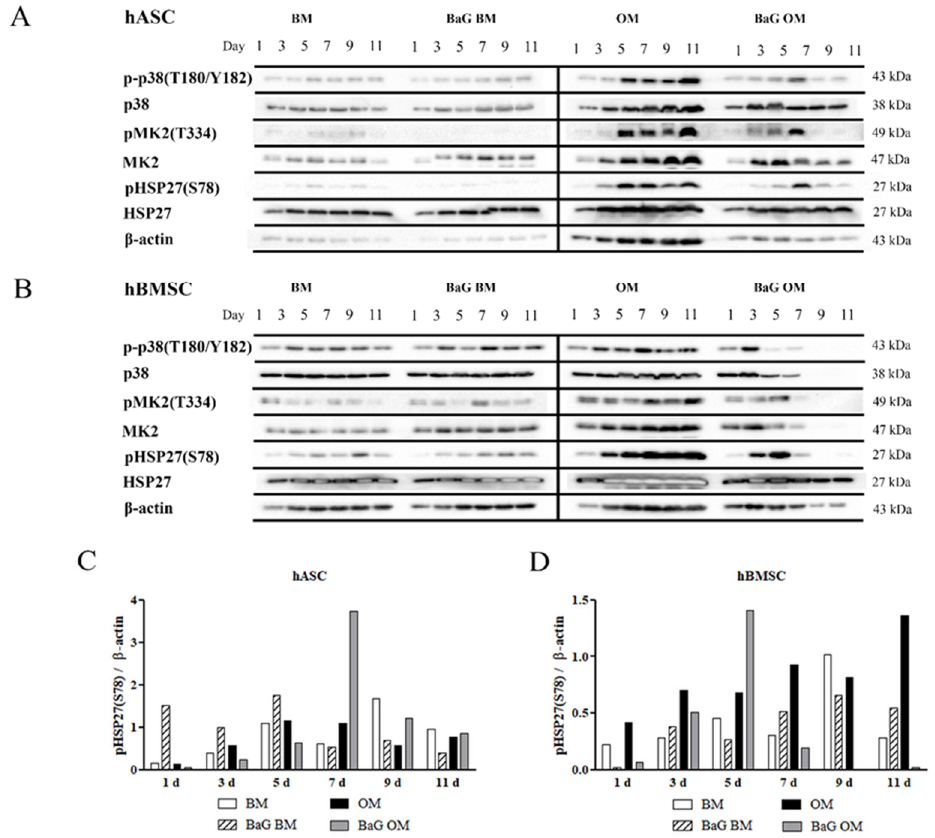
Figure 2. Timeline of p38/MK2/HSP27 activation in hASCs and hBMSCs. ( A , B ) hASCs and hBMSCs were cultured in BM, BaG BM, OM, and BaG OM for 1, 3, 5, 7, 9, and 11 days, and analyzed with Western Blotting and immunodetection. The figure presents cropped blots of p-p38, p38, pMK2, MK2, pHSP27(S78), HSP27, and β -actin of the representative donor cell lines. Full-length blots are presented in Figure S4. ( C , D ) Semi-quantification of the pHSP27(S28) bands presented normalized to β -actin in hASCs and hBMSCs. Abbreviations basic medium, BM; osteogenic medium, OM; and bioactive glass, BaG.